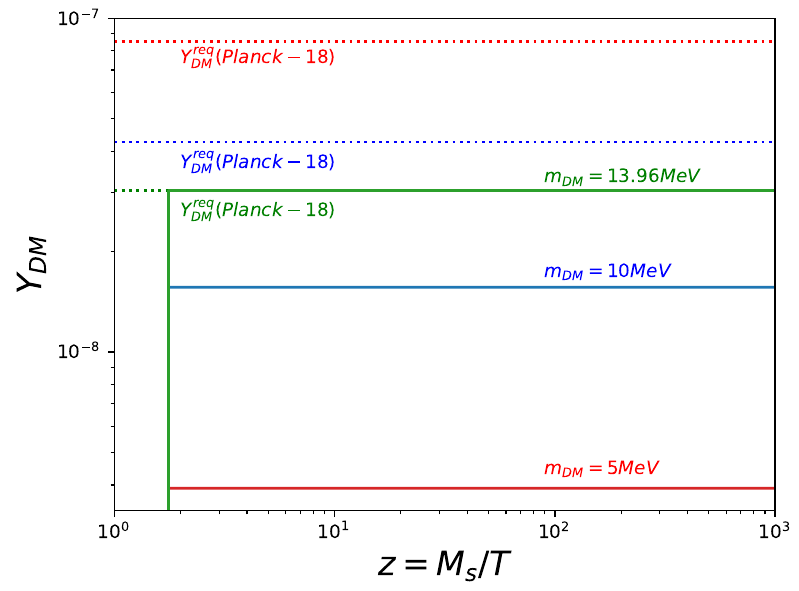
Figure 7 . Comoving density of FIMP DM for